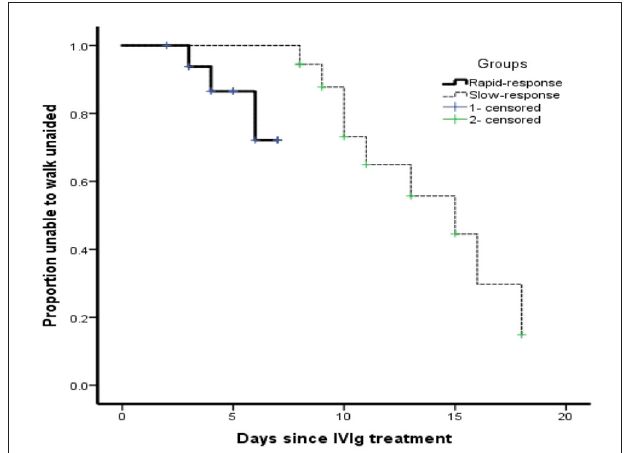
FIGURE 2 | Clinical recovery of patients with Guillain-Barré syndrome in relation to the rate of treatment response within 1 month after onset. The Kaplan–Meier analysis of patients with Guillain-Barré syndrome in children regaining the ability to walk unaided (Hughes Functional Grading Scale of 2) in relation to the different response rates after initiating intravenous immunoglobulin treatment within 1 month after